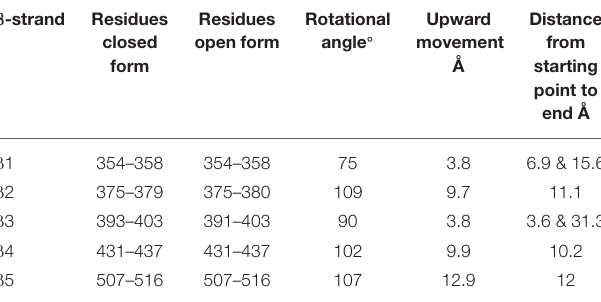
TABLE 1 | Conformational changes and rotational angles of β -stands of RBD between open and closed conformation. β -strand Residues Distance Upward Residues Rotational movement open form angle ◦ closed Å form